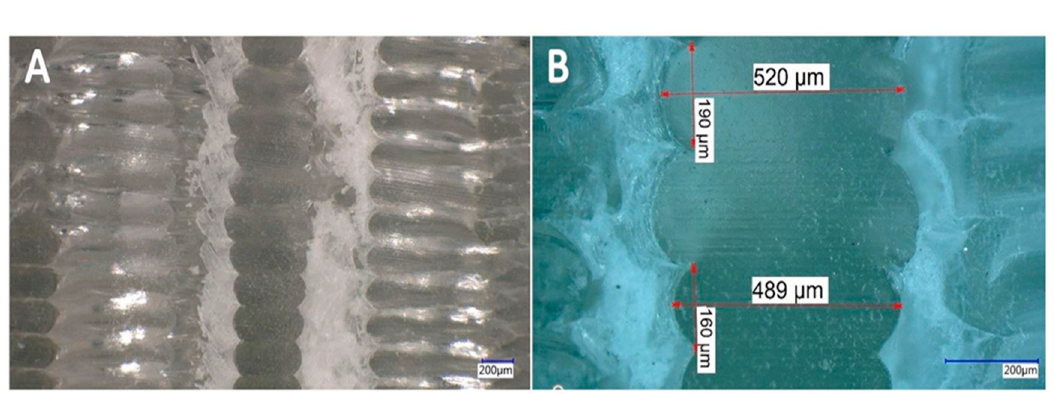
Figure 14. Microscopic cross-section image of 3D-printed sample with 1.6 ILD after compression test (cyclic loading–unloading). ( A ) 100× magnification setting, ( B ) 300× magnification setting.